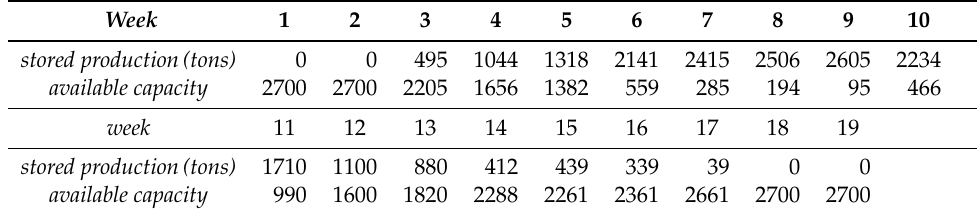
Table 5. Stored production and available capacity by week for the case